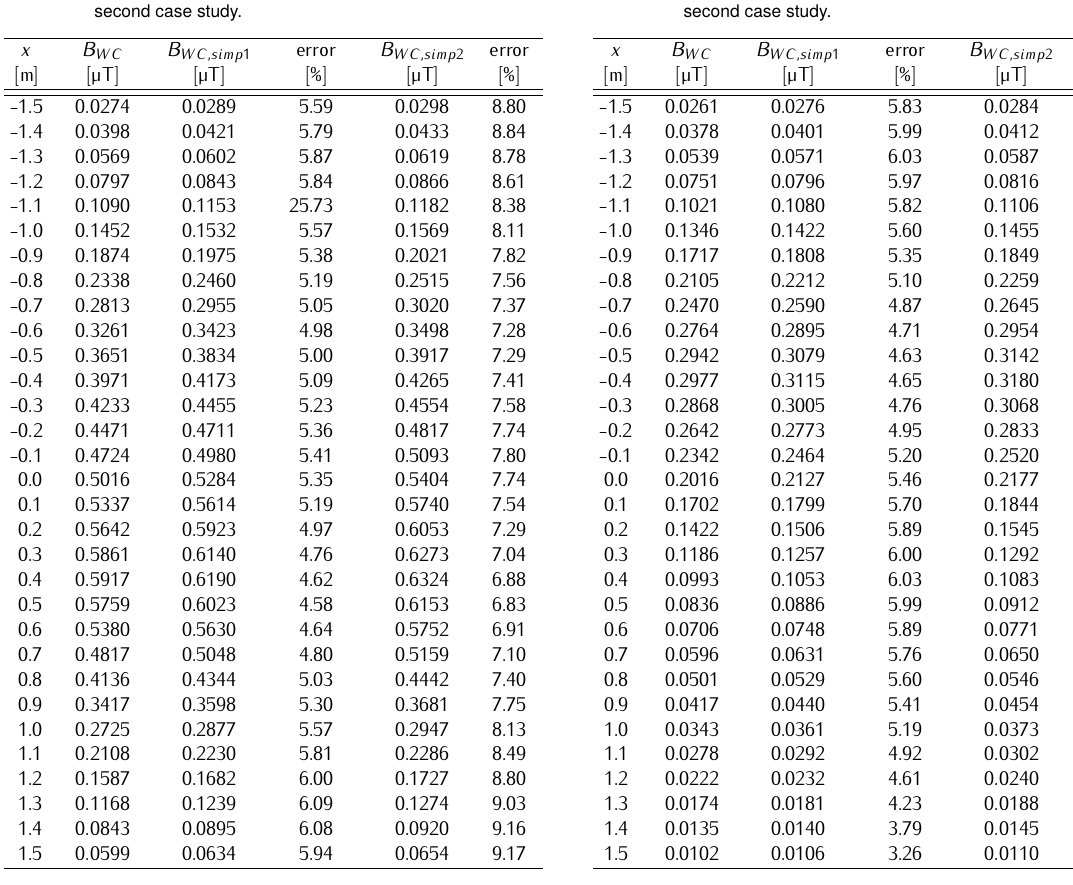
Table 5. B WC , B WC,simp 1 , B WC,simp 2 vs. distance x from the cable axis and relevant percent errors with respect to B WC for the